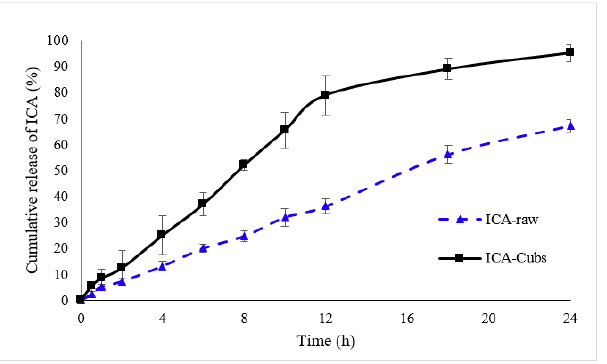
Figure 7. In vitro comparative release profiles of ICA-raw and ICA-Cubs in the phosphate buffer (pH 7.4). Data are expressed as the mean ± SD (n = 3).